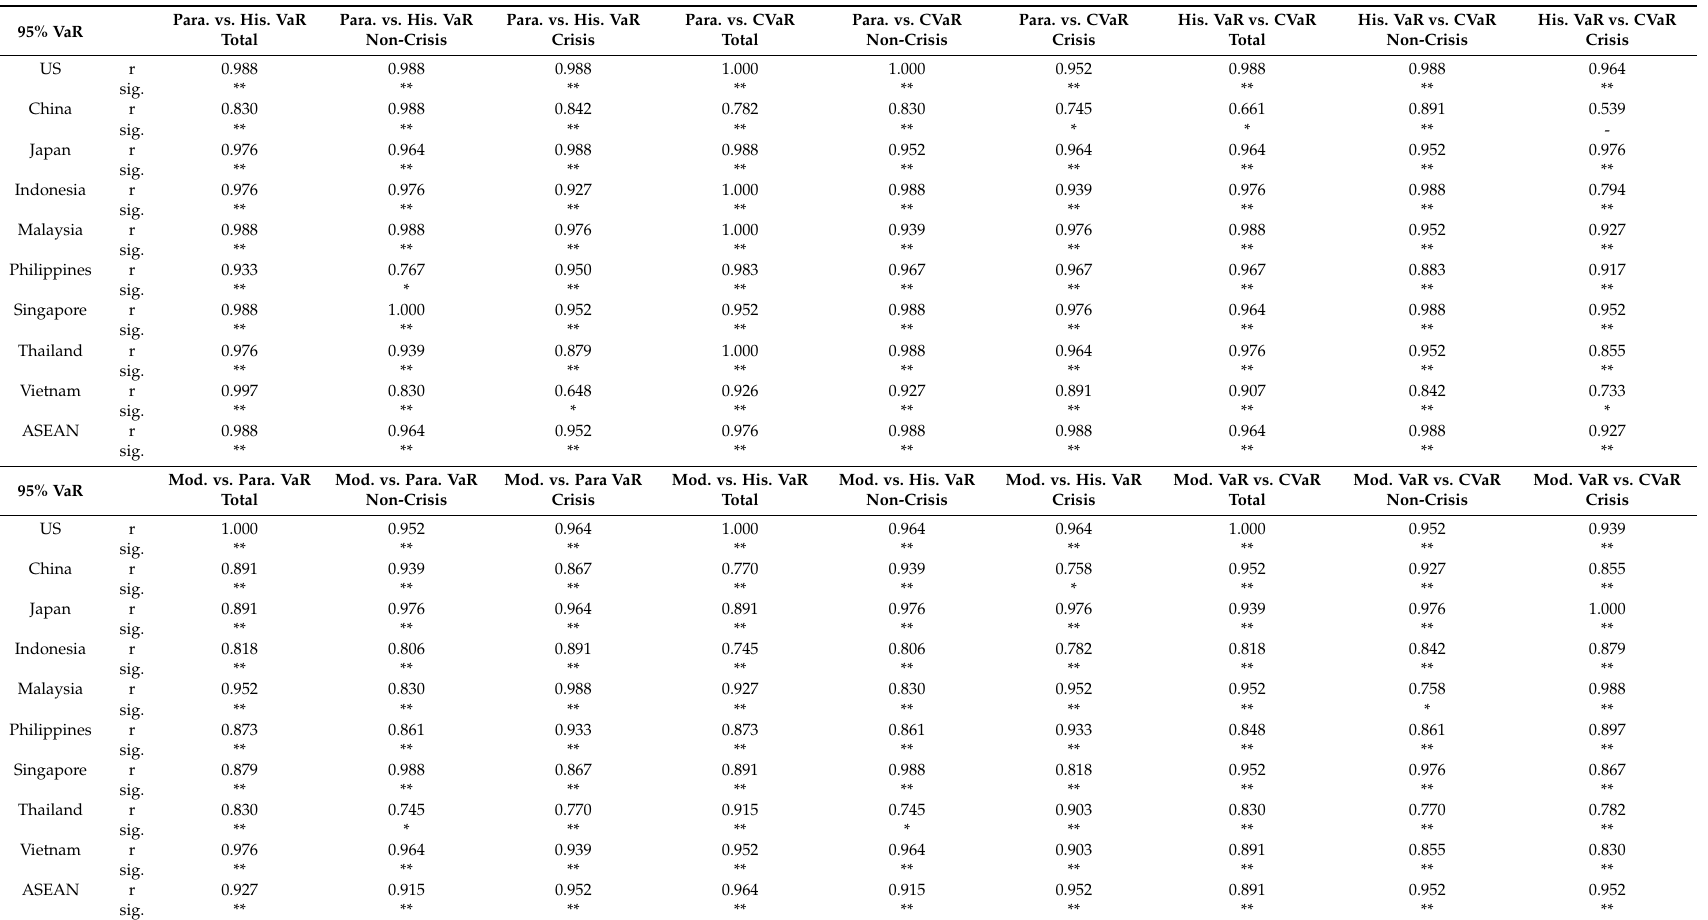
Table 2. Ranking correlation of industries between different metrics 95%